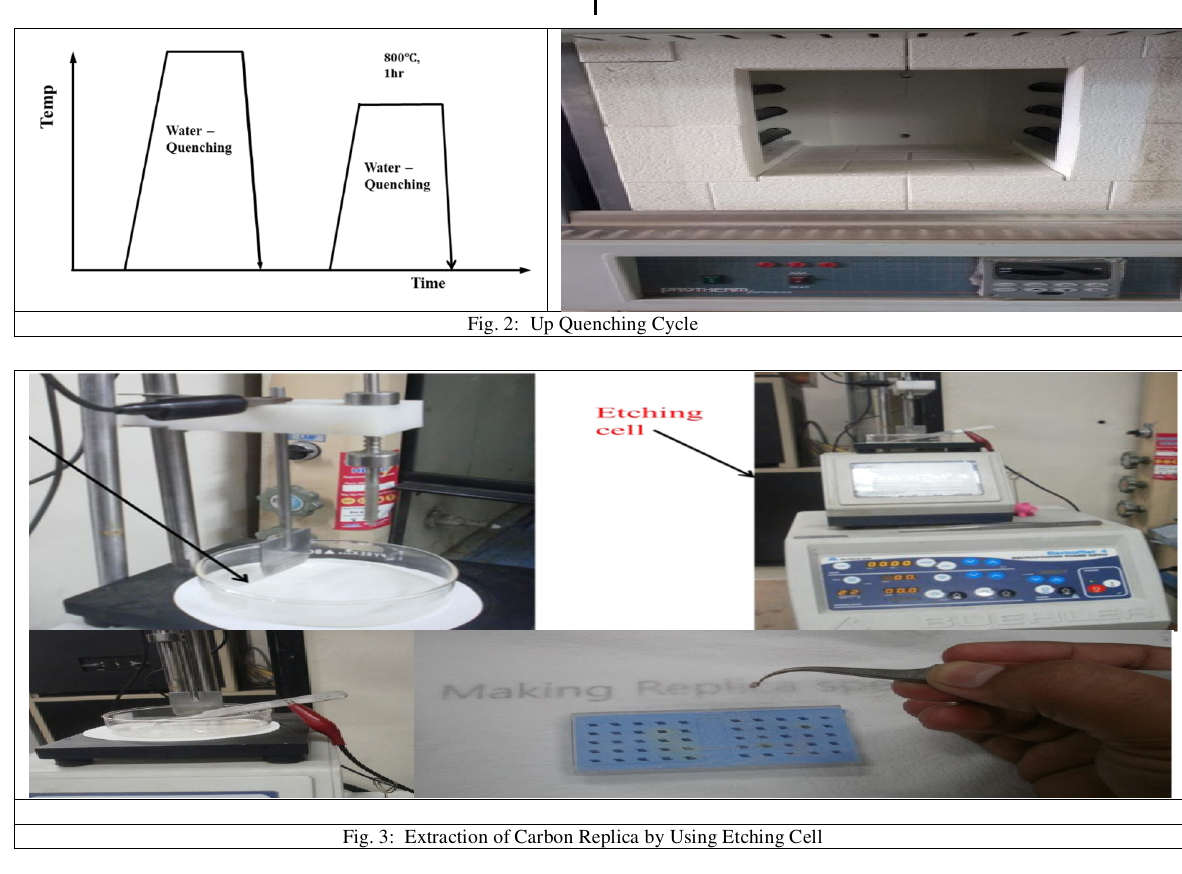
Fig. 3: Extraction of Carbon Replica by Using Etching